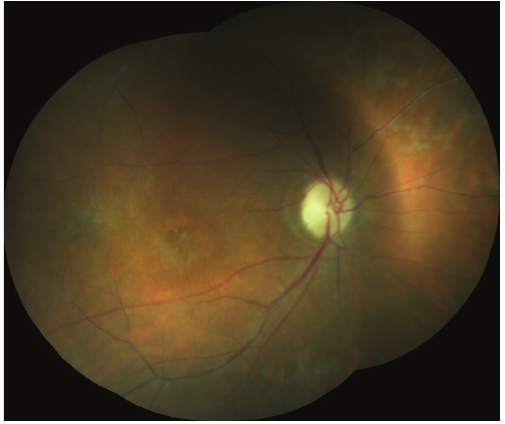
Figure 6: Macular edema and epiretinal membrane as complication of periphlebitis in patient with MS (left